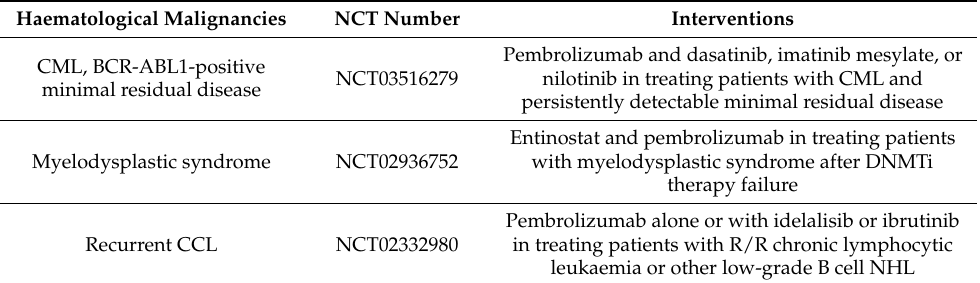
Table 3. Main clinical trials underway in haematological malignancies of combined strategies against MDSCs and